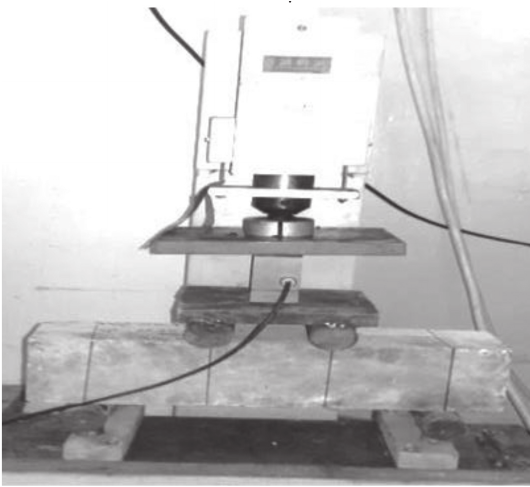
Figure 4: Specimen under bending machine.